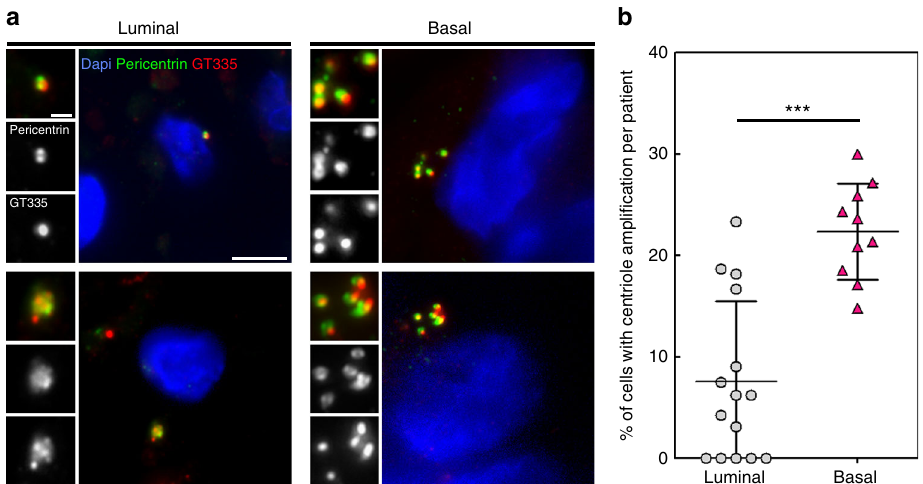
Fig. 4 Basal-like human breast carcinomas display more centriole ampli fi cation than luminal breast carcinomas. a Representative immuno fl uorescence images of sections of human breast tumours showing normal centriole number (2) in interphasic cells of luminal breast carcinoma (upper left panel), and centriole ampli fi cation (>4), in both luminal (lower left panel) and basal-like (right panel) breast carcinomas. We labelled centrioles using the centriolar marker GT335, which labels tubulin glutamylation, a modi fi cation of tubulin present in centrioles, in co-localisation with the PCM marker, pericentrin. Tissue sections were also stained with DAPI (blue). Please note that we focused our analysis on interphase cells, as it is very dif fi cult to fi nd mitotic fi gures in breast tumours. Scale bar 5 µ m, insets 1 µ m. b Percentage of cells displaying centriole ampli fi cation in each of the 15 patients with luminal breast carcinomas (average 8% ± 2) and in each of the 10 patients with basal-like carcinomas ((on average 22% ± 2), p = 0.0004, Mann – Whitney test). Please note that only structures positive for both pericentrin and GT335 were taken into consideration to avoid false positives. All basal-like carcinomas (10 out of 10 patients) exhibited centriole ampli fi cation while it was not detected in 5 out of the 15 luminal carcinomas. Between 20 and 133 cells were analysed for each patient (see Supplementary Fig. S6). The bar represents the mean ±